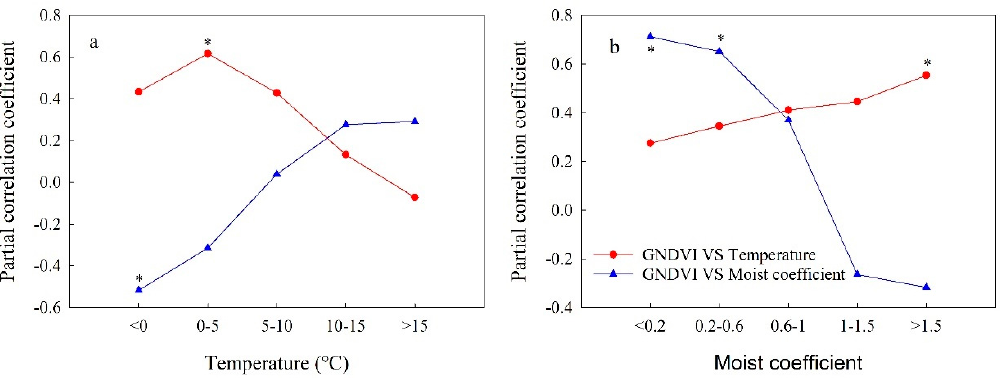
Figure 7. The partial correlation coefficient between the GNDVI and climatic factors under different conditions of ( a ) temperature and ( b ) moisture on the QTP during 2000–2019. * p < 0.05.